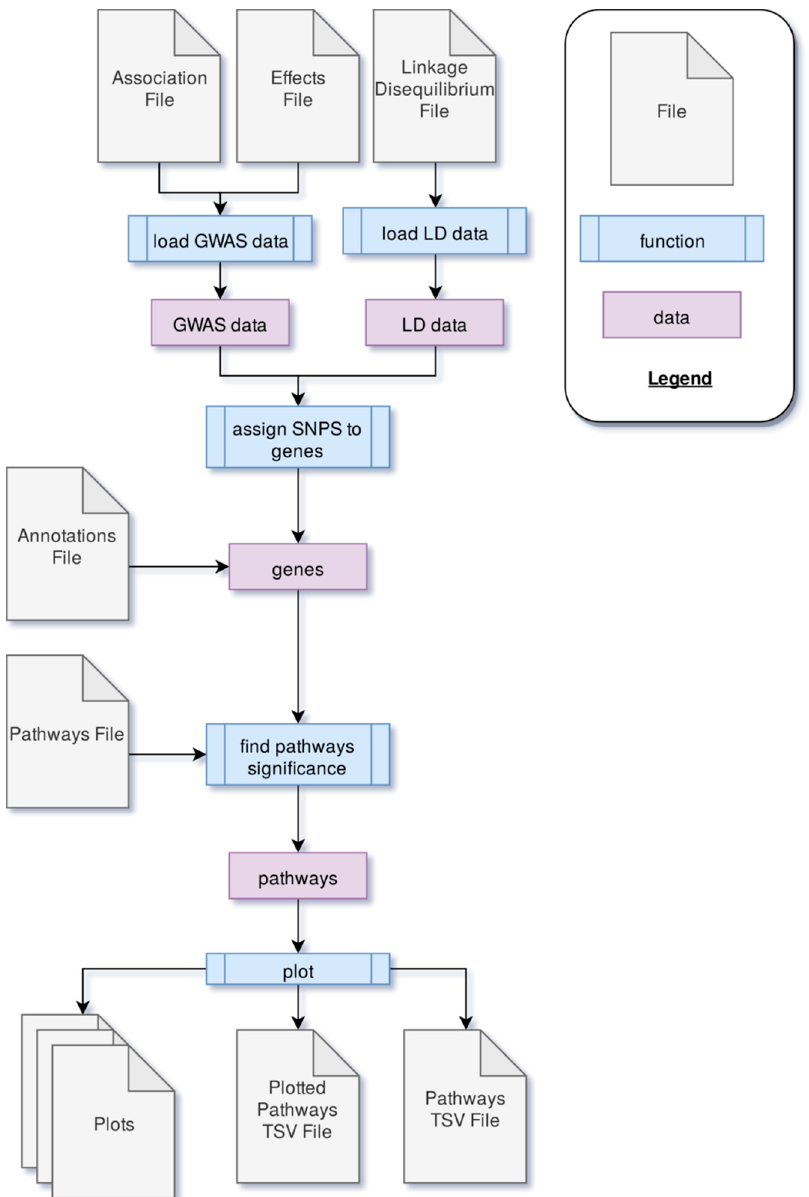
Figure 2. The process through which PAST processes genome-wide association study (GWAS) output data to identify metabolic pathways significantly associated with a trait of interest.